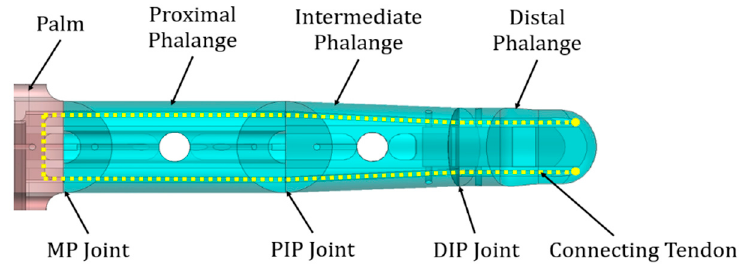
Figure 4. Shaft-less connection structure of finger.